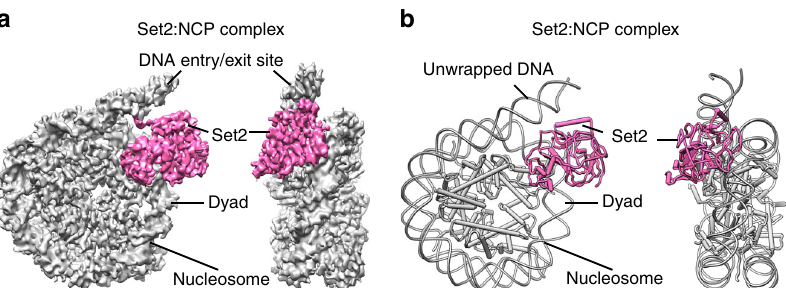
Fig. 1 Cryo EM structure of Set2 methyltransferase bound to the NCP. a Cryo-EM map of Set2 bound to NCP at 3.8 Å. NCP is shown in gray and Set2 in pink. Set2 stabilizes NCP with the unwrapped DNA. b Model for cryo-EM map of the Set2 bound to NCP. NCP is shown in gray and Set2 in pink